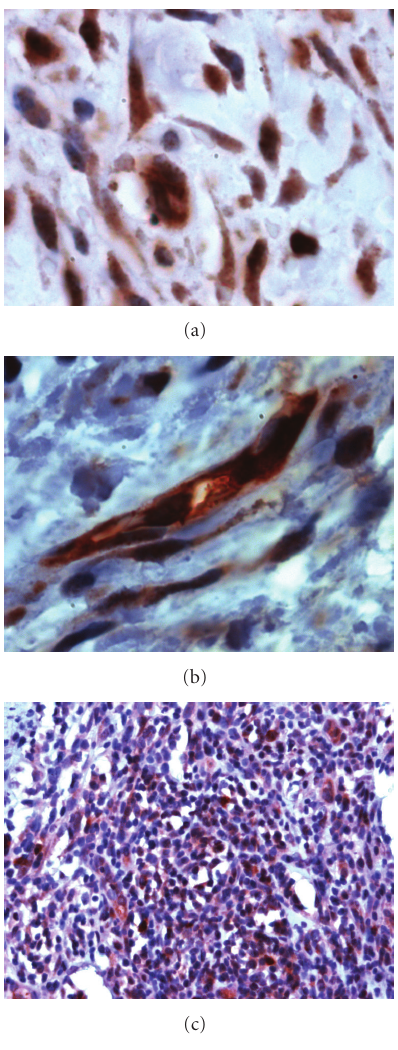
Figure 2: Bronchial wall alterations in bronchial allografts. Macrophages, fibroblasts (a) and endothelial cells (b) stained postive for CRP in the bronchial wall. CRP positivity was abundant in fresh obliterative plugs on the follow-up day 11 (c). Immuno- cytochemistry against CRP: hematoxylin counterstaining, original magnification 100x objective (a,b), and 20x objective